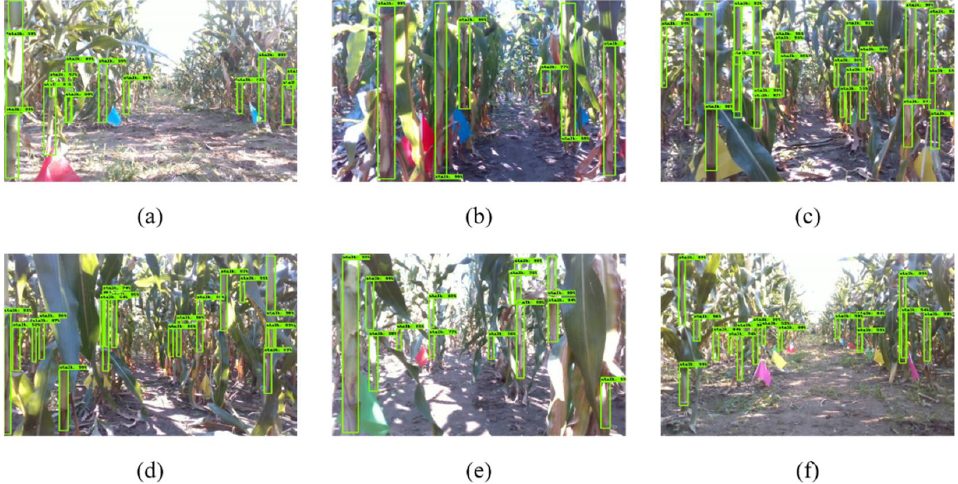
Figure 10. The stem detection by Faster RCNN under natural scenarios. ( a ) long-distance and strong lighting intensity; ( b ) close-distance and backlighting; ( c ) close-distance; ( d ) backlighting; ( e ) strong lighting intensity; ( f ) long-distance.